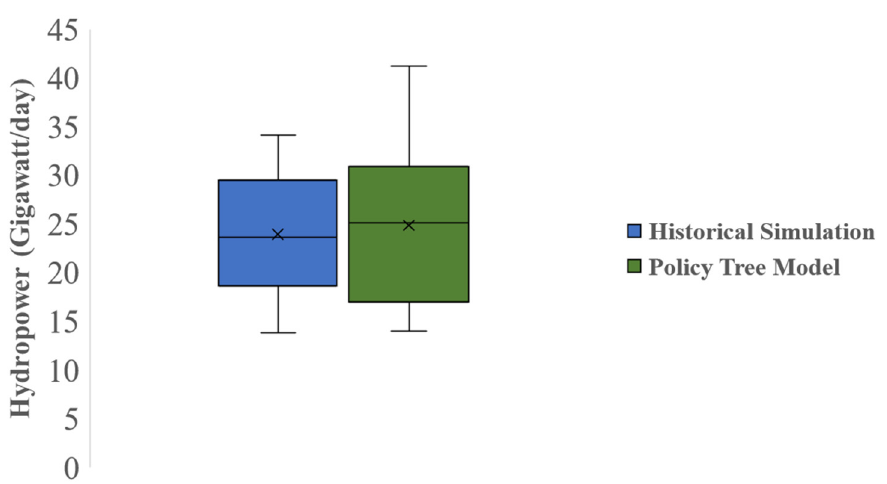
Figure 16. Daily hydropower generation in historical simulation and policy tree model.